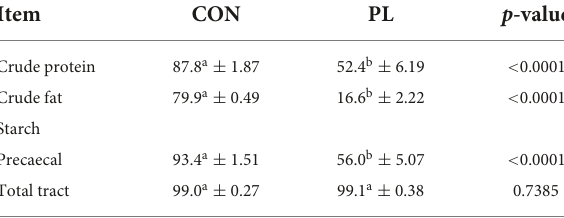
TABLE 3 Apparent total tract digestibility (%) of protein, fat, and precaecal as well as total tract true digestibility (%) of starch of the animals in both groups (mean ±